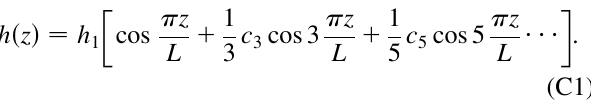
for four smooth mod-